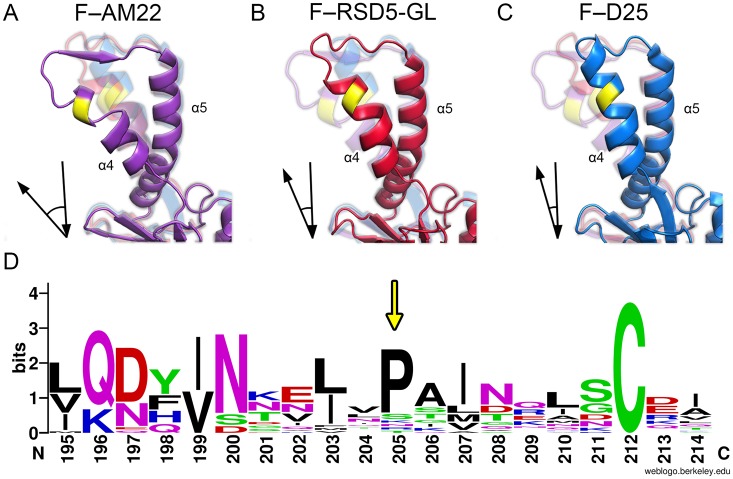
Alternative conformations of site Ø.(A–C) Ribbon representation of prefusion RSV F from the three indicated antibody complexes. The alternative conformations structurally diverge near proline 205 (colored yellow). Each panel (A–C) also contains faded versions of the two other conformations for direct comparison. Arrows in the bottom left corner of each panel depict the angle between α4 and α5 of the conformation displayed in that panel. (D) A WebLogo generated from representative sequences of all known pneumovirus and paramyxovirus fusion proteins corresponding to the α4-helix and α4–α5 loop indicates a well-conserved proline (indicated by the yellow arrow). Residue numbering is based upon the human RSV fusion protein sequence from strain A2.